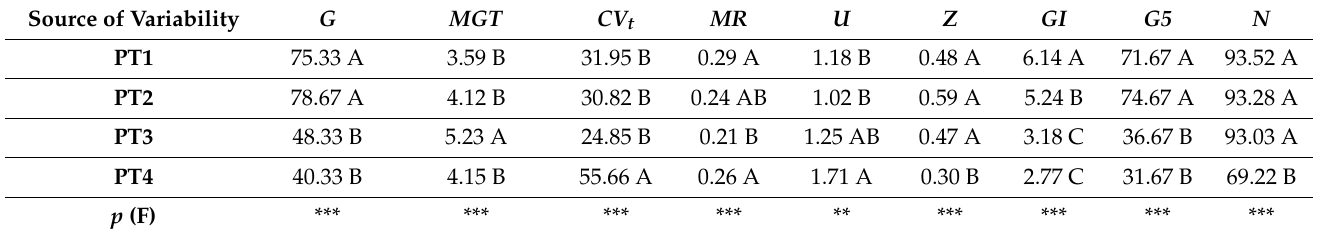
Table 5. Differences between priming treatments for the germination parameters of natural winter savory Population 1 in the second phase of the experiment under drought